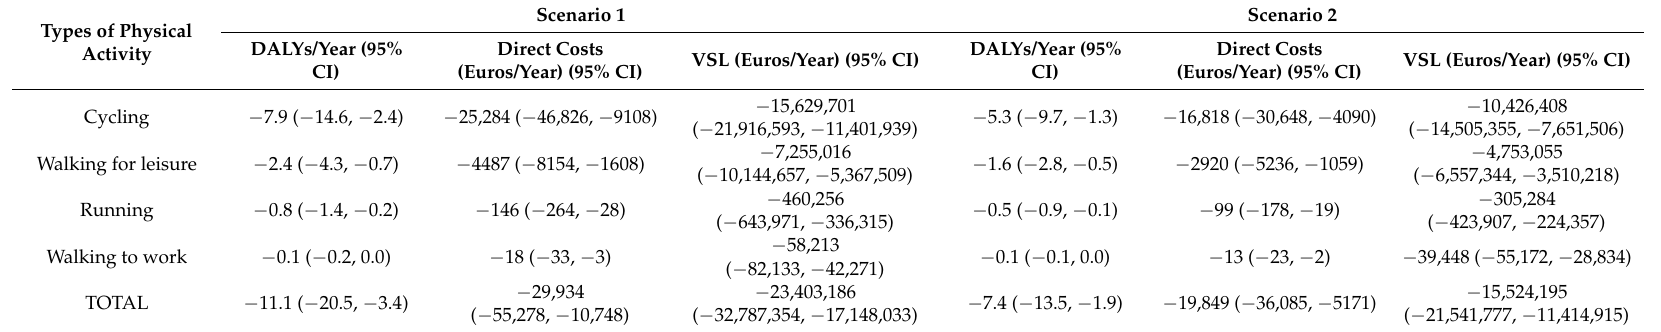
Table 3. Results by type of physical activity, in annual DALY, direct health-care costs, and value of statistical life (Scenario 1 and Scenario